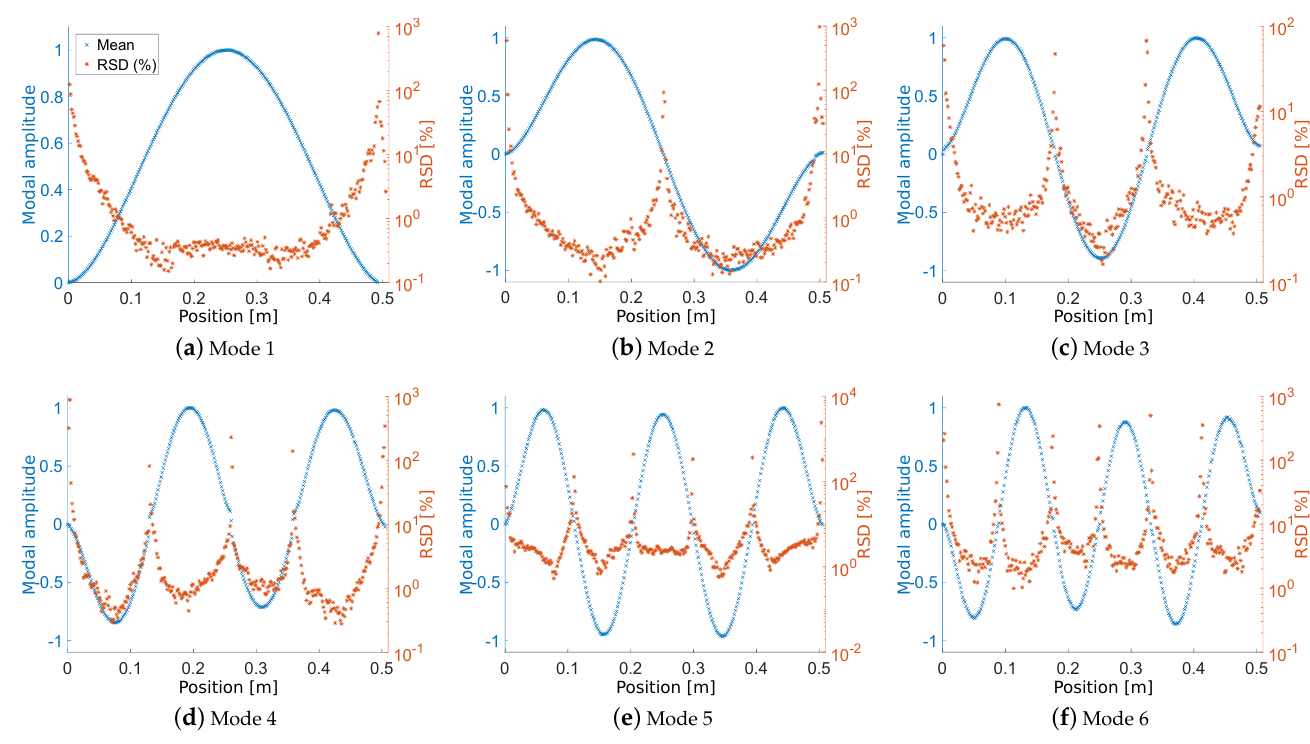
Figure 18. First six mode shapes obtained from the DIC measurements for the clamped–clamped beam. For the frequencies and damping ratios, the values obtained from the DIC measure- ments and the accelerometers are reported in Tables 2 and 3, respectively. Table 2. Average frequencies (in Hz) determined from DIC measurements and accelerometers for the clamped–clamped